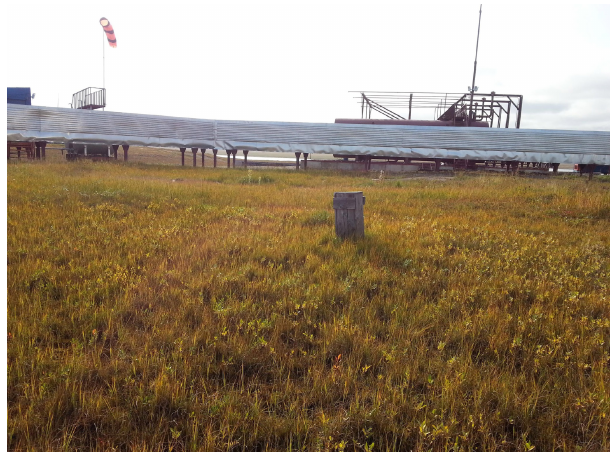
Figure E3. Location of the 2006 borehole (wooden box) showing the proximity of the new water supply system (a silver metal struc- ture extending above the tundra surface since 2013).